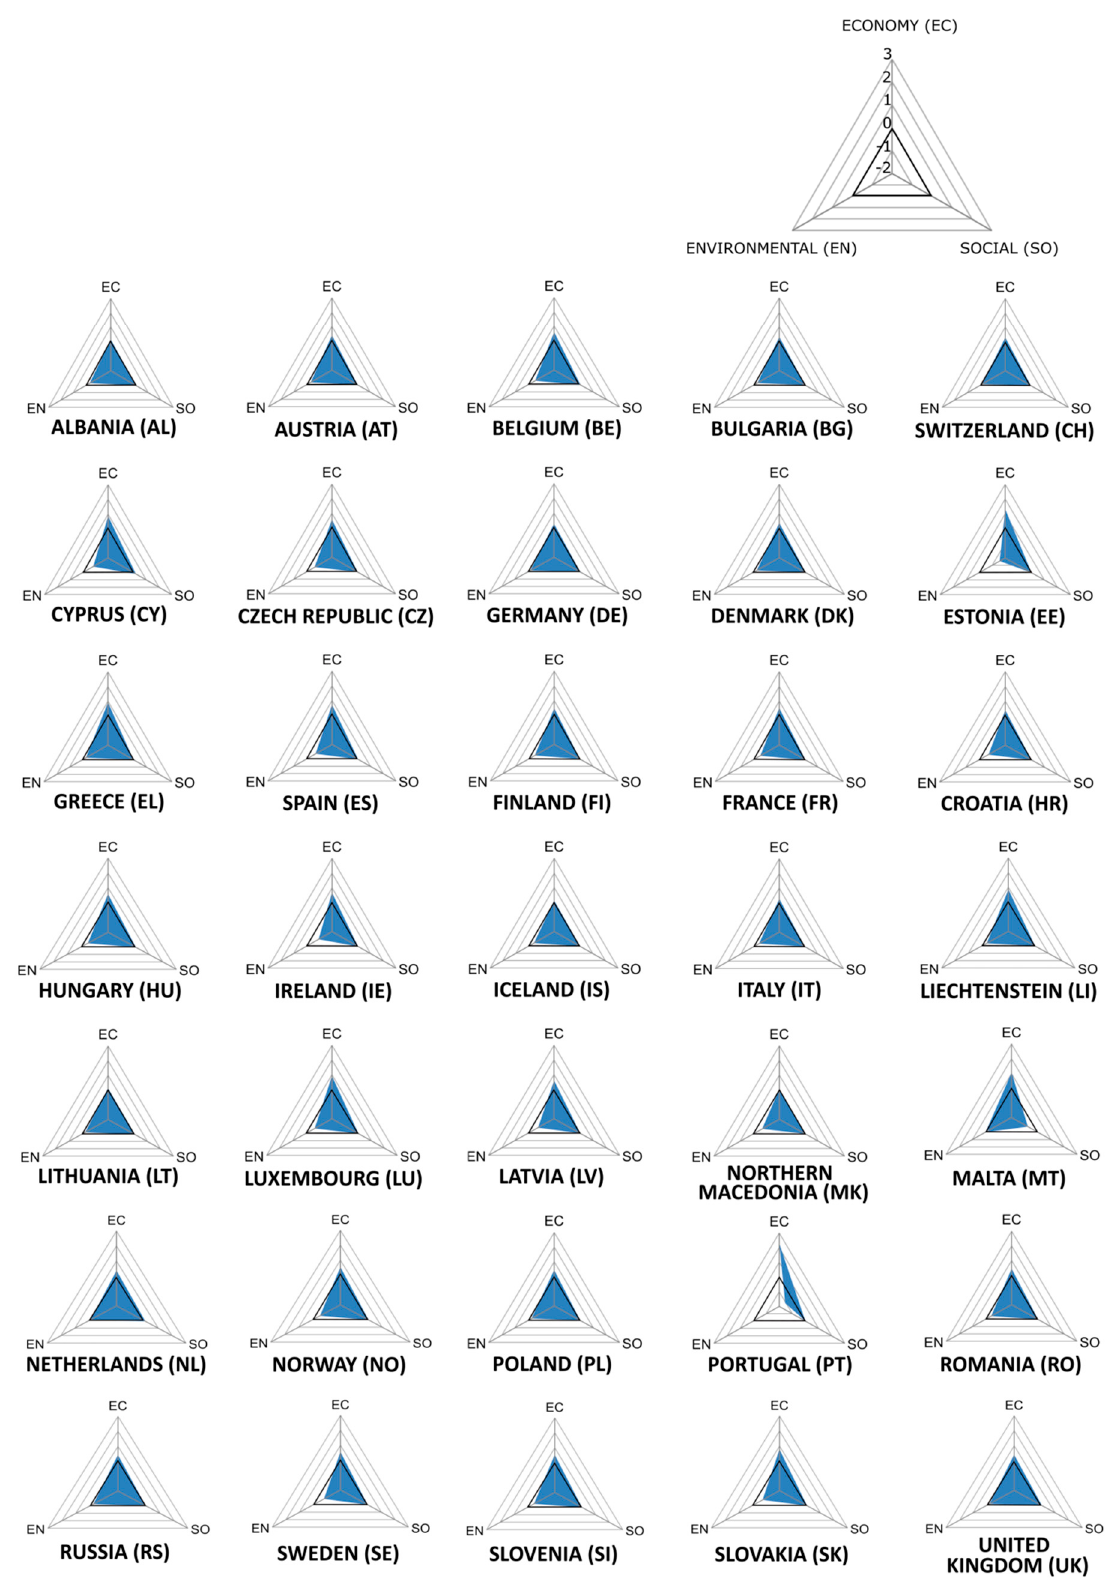
Figure A4. Sustainability assessment of local change directions in country.